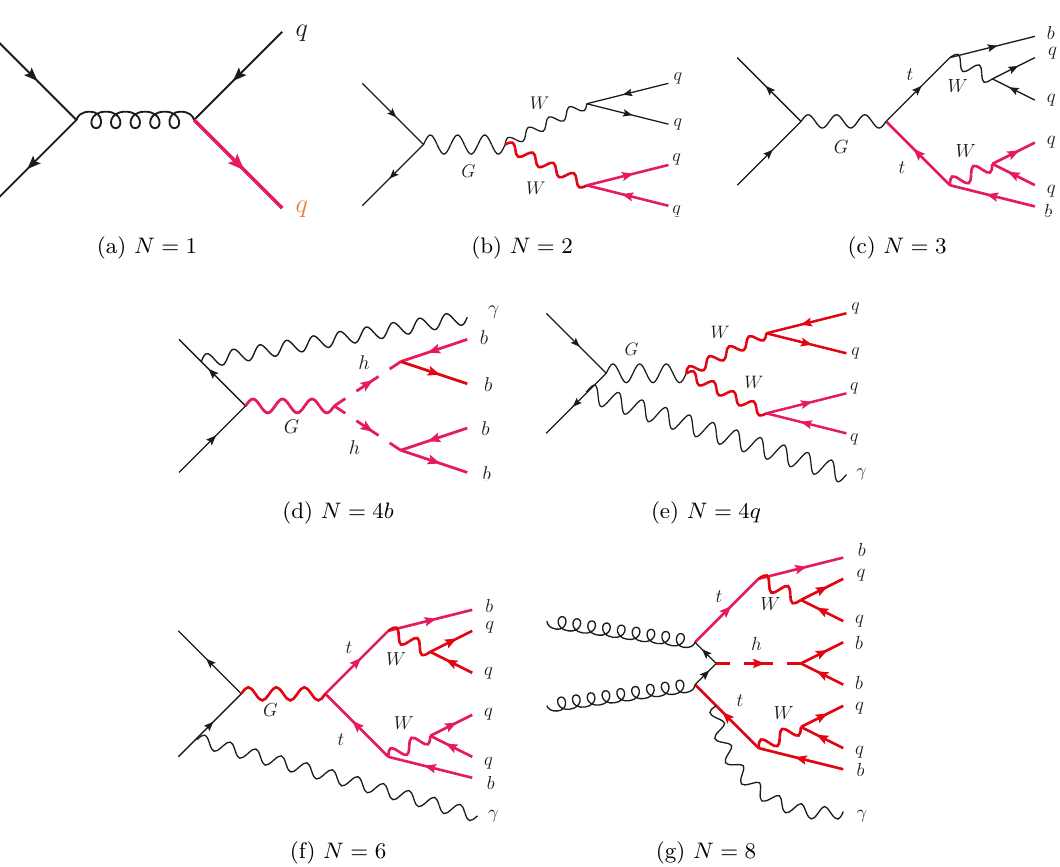
Figure 1 . Feynman diagrams for processes which generate jets with N = 1 , 2 , 3 , 4 b, 4 q, 6 , 8 hard sub-jets. The lines in red indicate the components which are required to be truth-matched to the jet. See text and table 1 for further generation